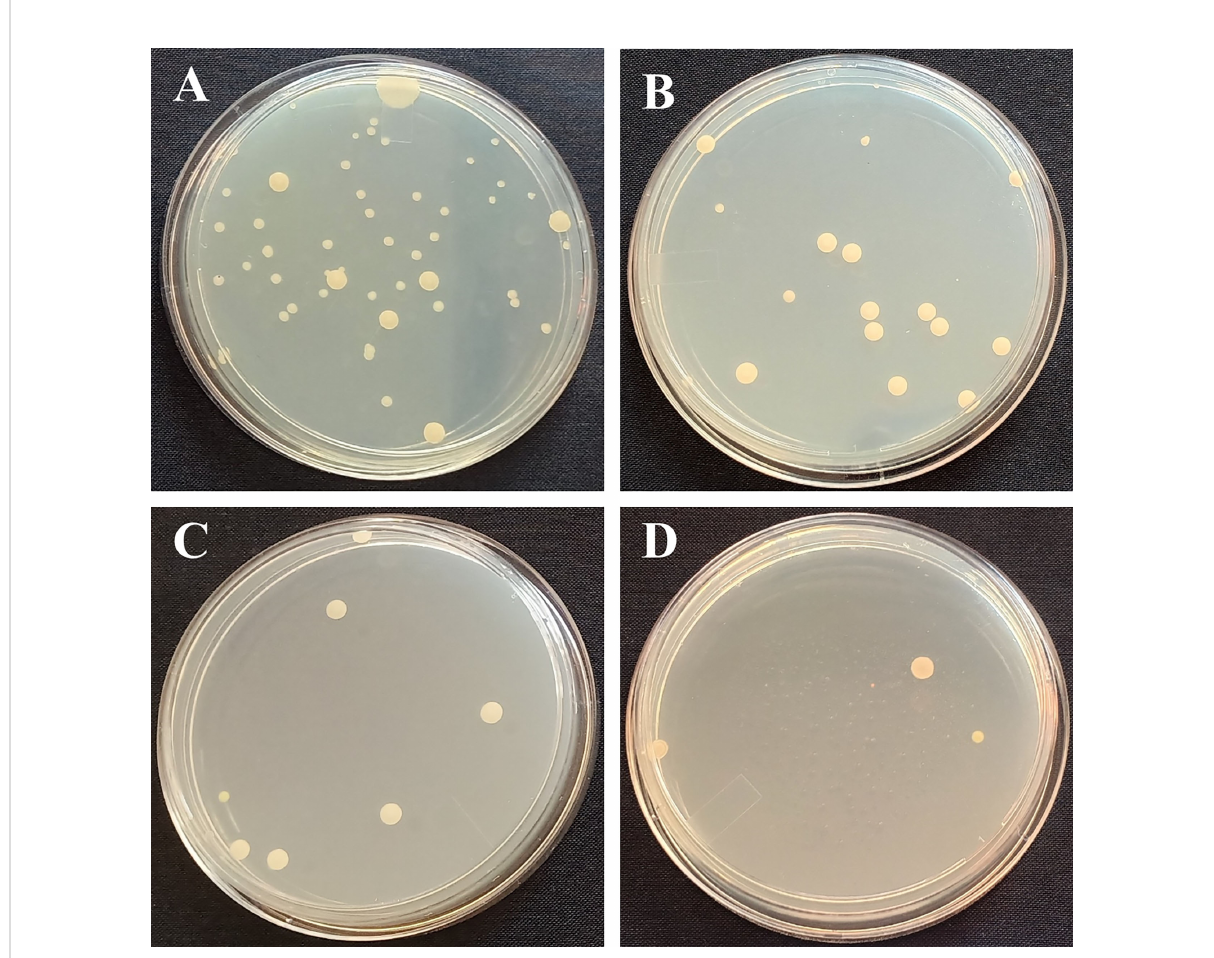
FIGURE 4 Photographs of petri dishes of (A) Control, (B) GO at 1 µL L − 1, (C) SNP 1 µL L − 1 , and (D) GO + SNP 1 µL L − 1